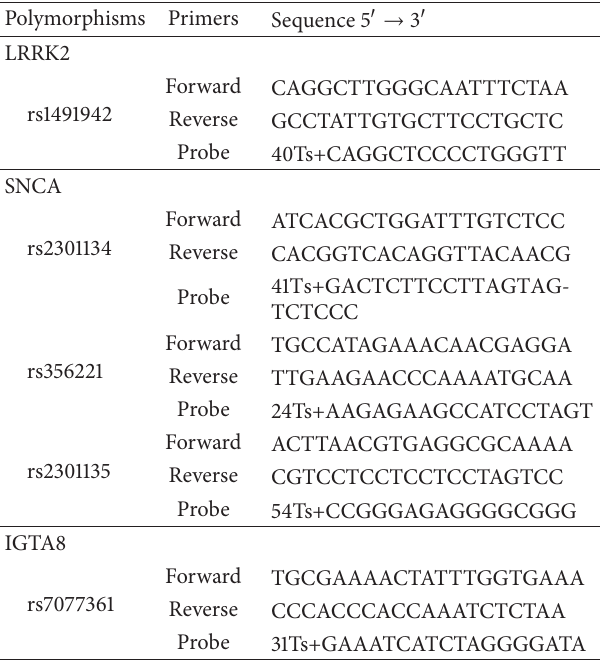
Table 2: PCR and Snapshot probe primer